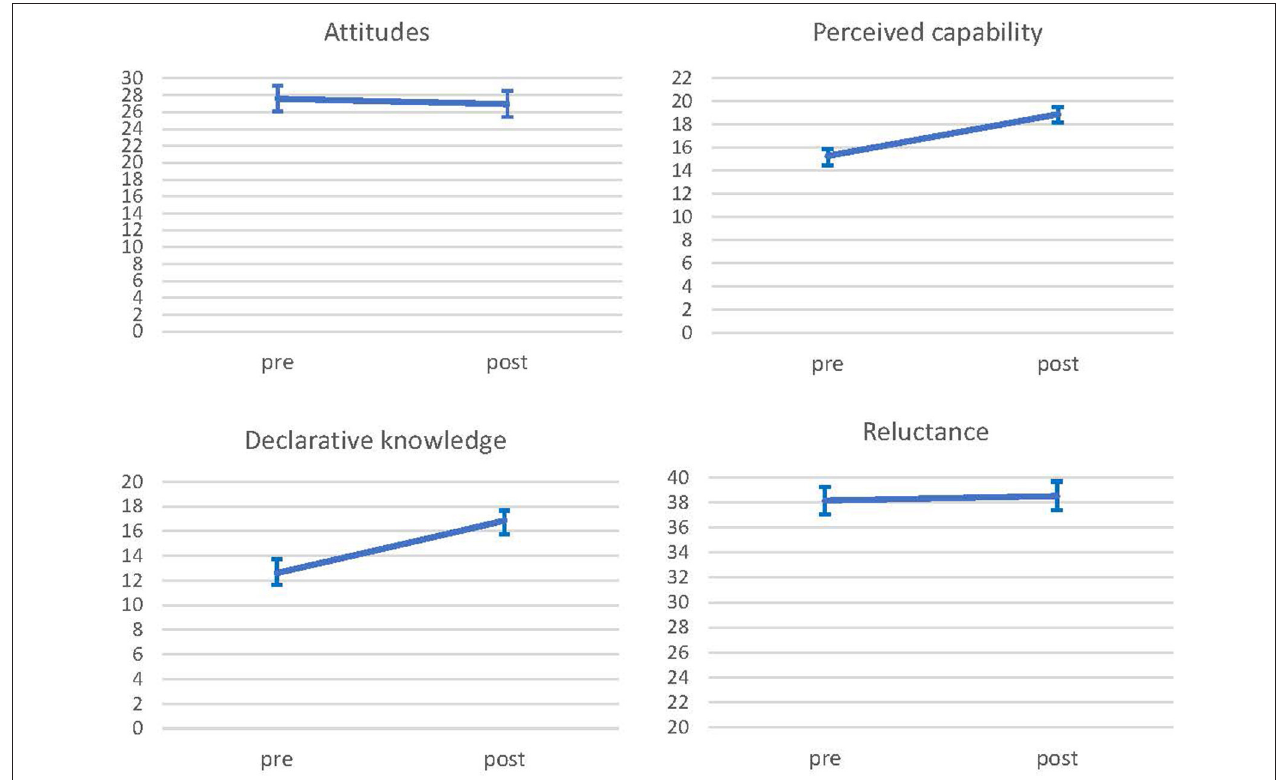
FIGURE 1 | Estimated marginal means of main outcome measure pre and post